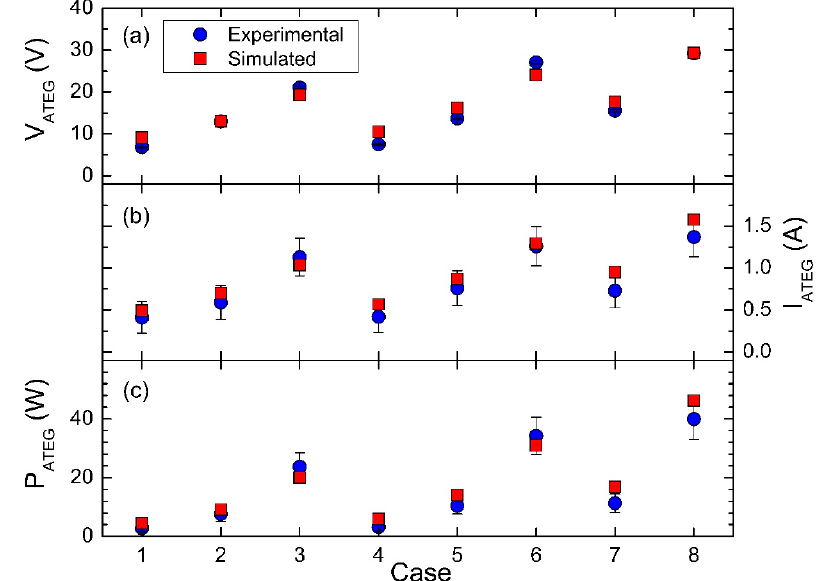
Figure 7. Experimental and simulated values of ( a ) ATEG voltage; ( b ) ATEG current; and ( c ) ATEG output power for the regimes shown in Table 3. output power for the regimes shown in Table